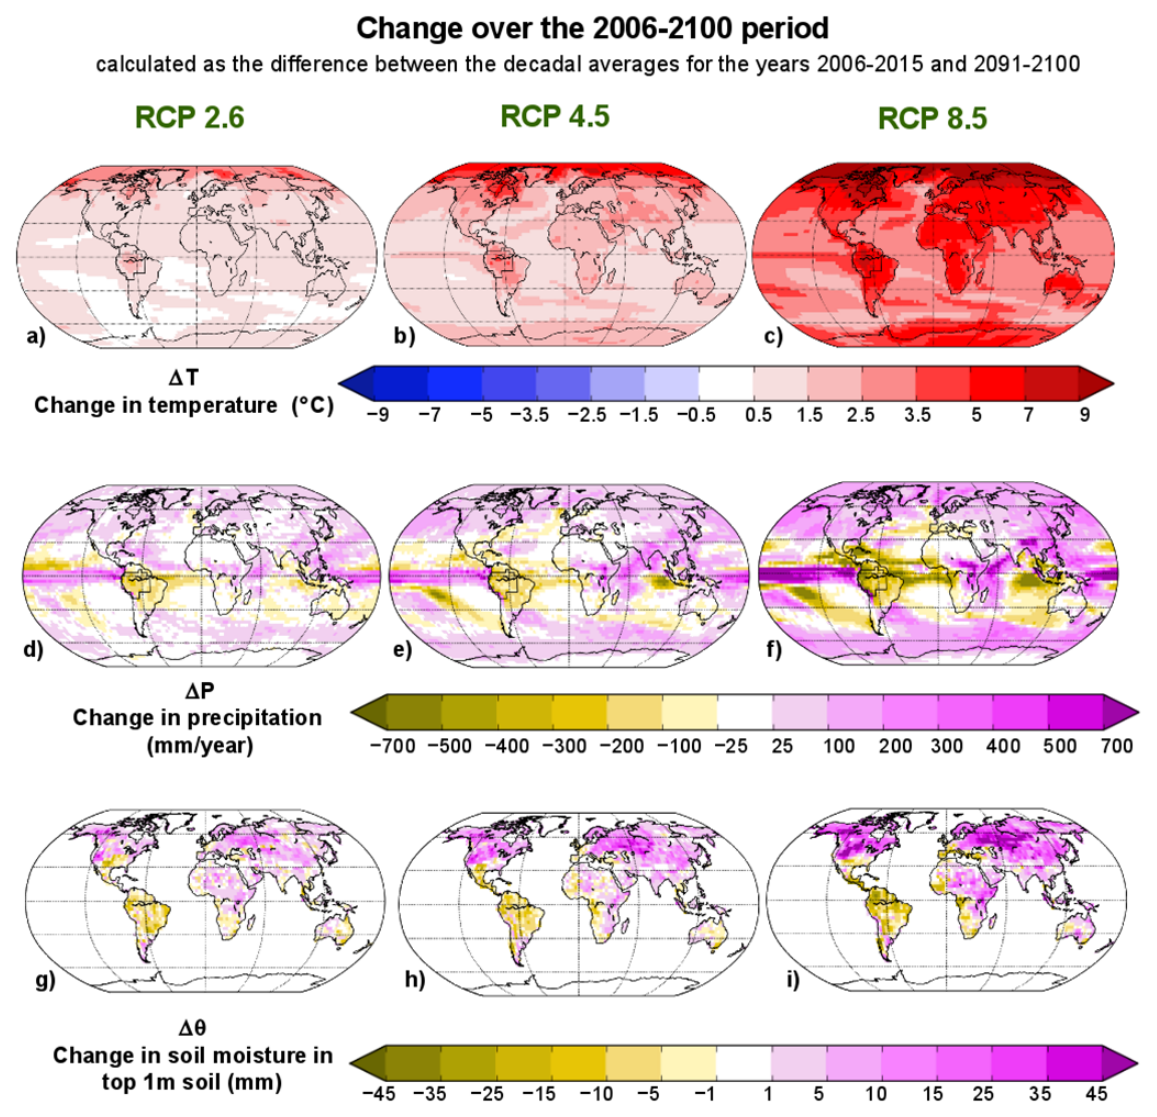
Figure 4. Geographic distribution of changes in temperature ( 1T ), precipitation ( 1P ) and soil moisture in the top 1m soil layer ( 1θ) over the 2006–2100 period in the three RCP